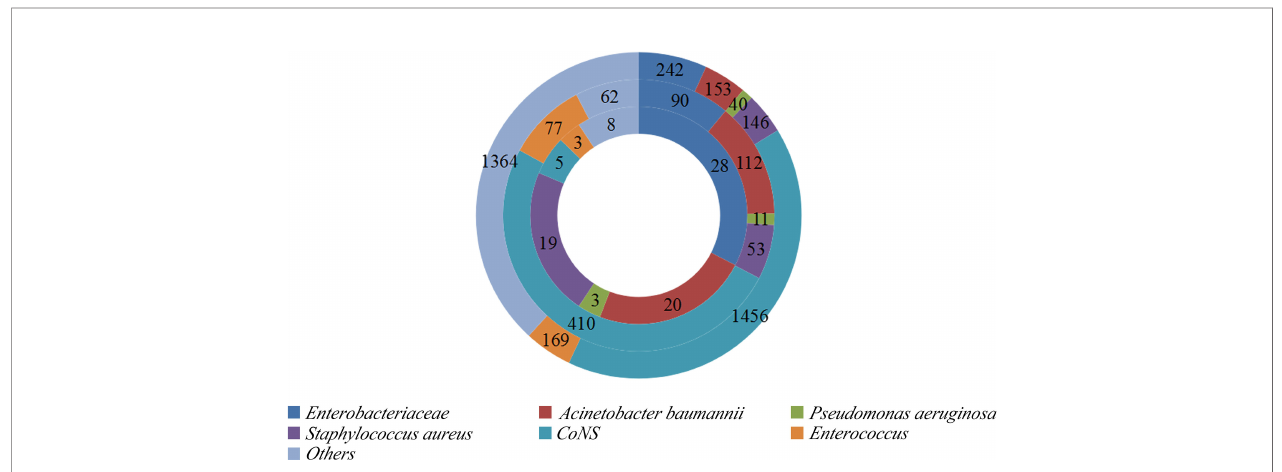
FIGURE 2 | Distribution of bacteria isolated from the cerebrospinal fl uid (CSF) of patients with nosocomial meningitis (NM). Outer ring : Distribution of bacteria. Middle ring : Distribution of multidrug-resistant (MDR) bacteria. Inner ring : Distribution of MDR bacteria causing NM mortality. CoNS , coagulase-negative staphylococci.